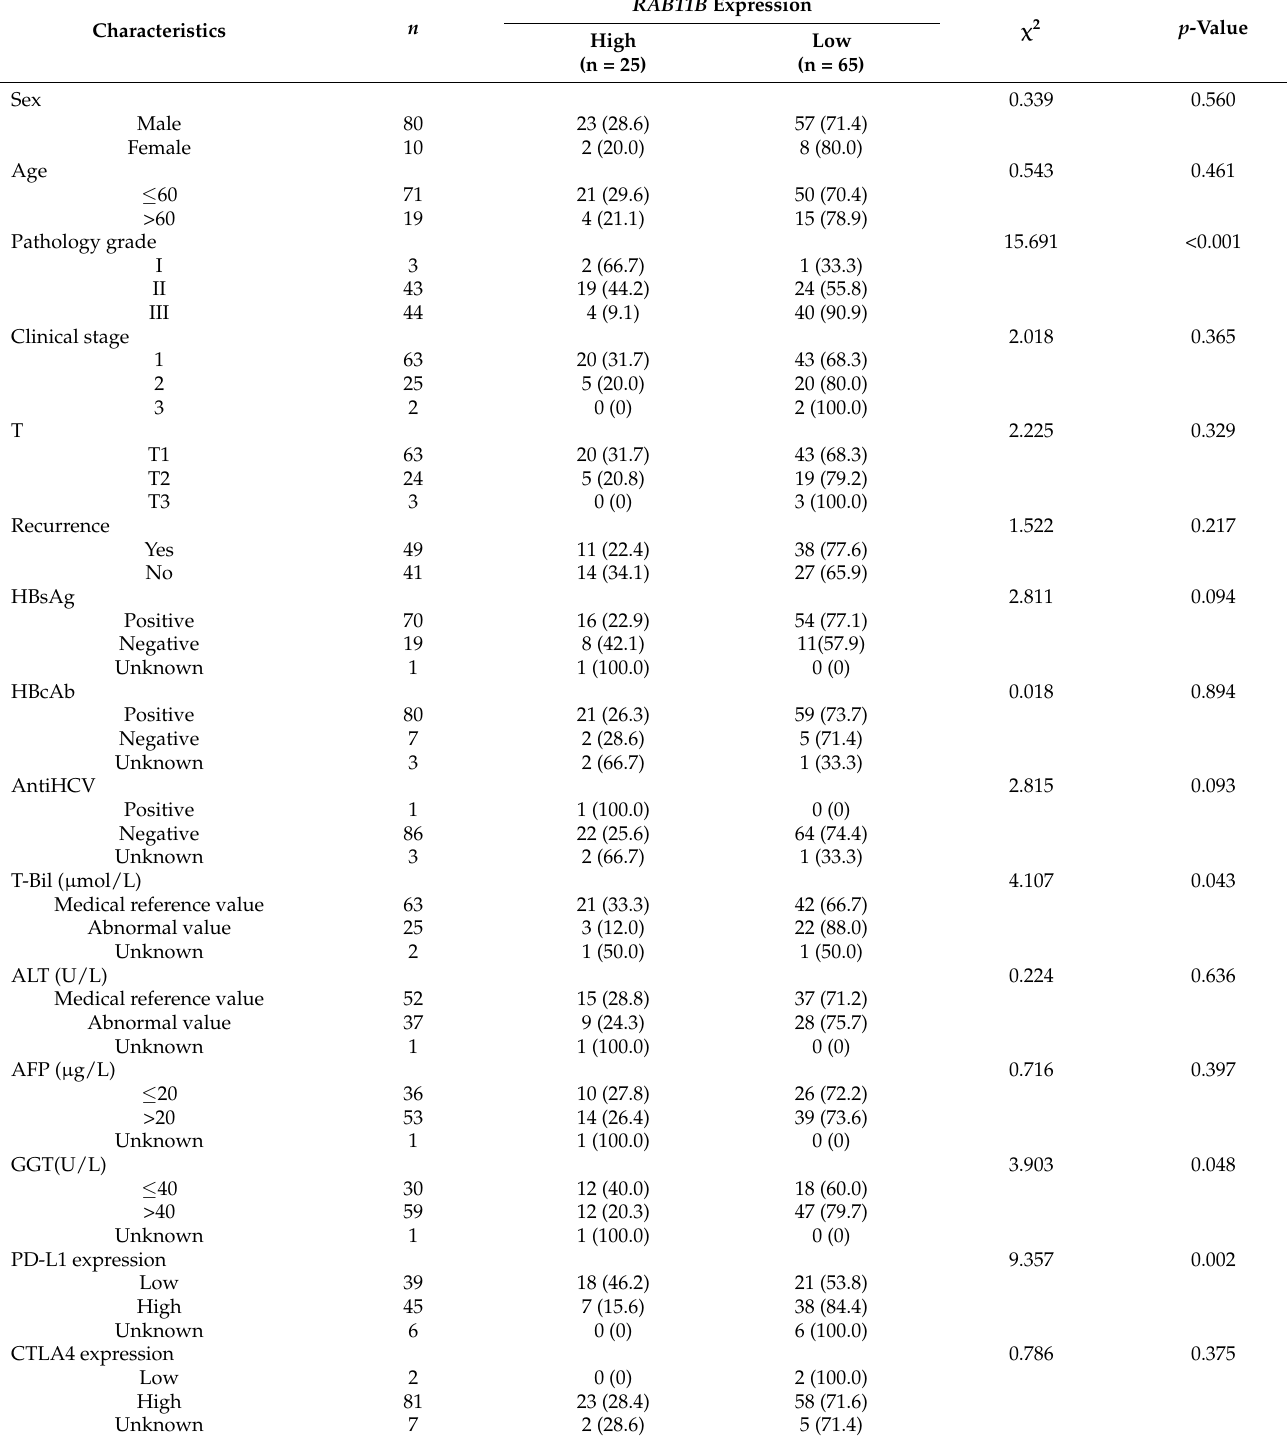
Table 4. Relationship between clinicopathological characteristics and expression of RAB11B protein in HCC